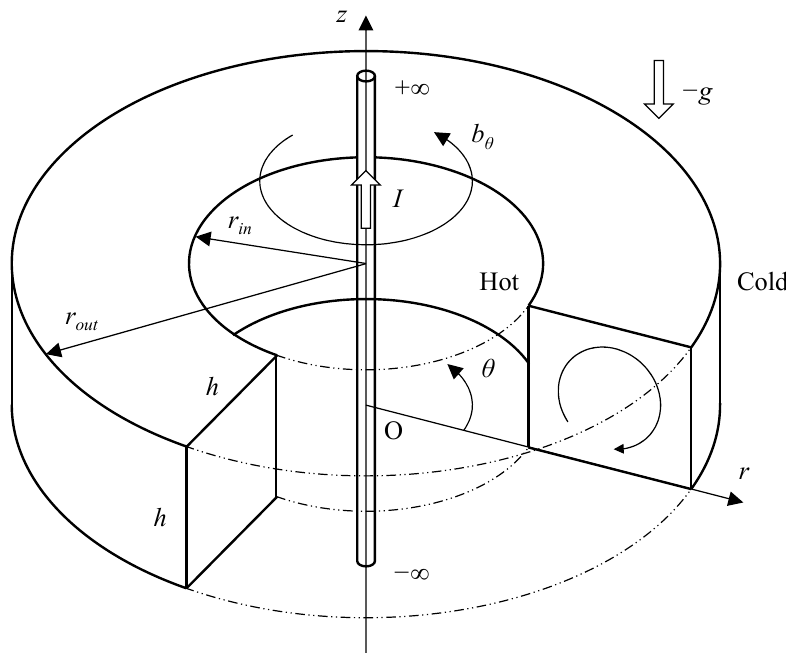
Figure 1. A schematic model. The inner wall is heated and the outer wall is cooled, both isothermally, while the top and bottom horizontal walls are adiabatic. Static azimuthal magnetic field is imposed by an electric coil placed at the central axis of the annular enclosure. The cross-sectional area is supposed to be square and the characteristic length is h .